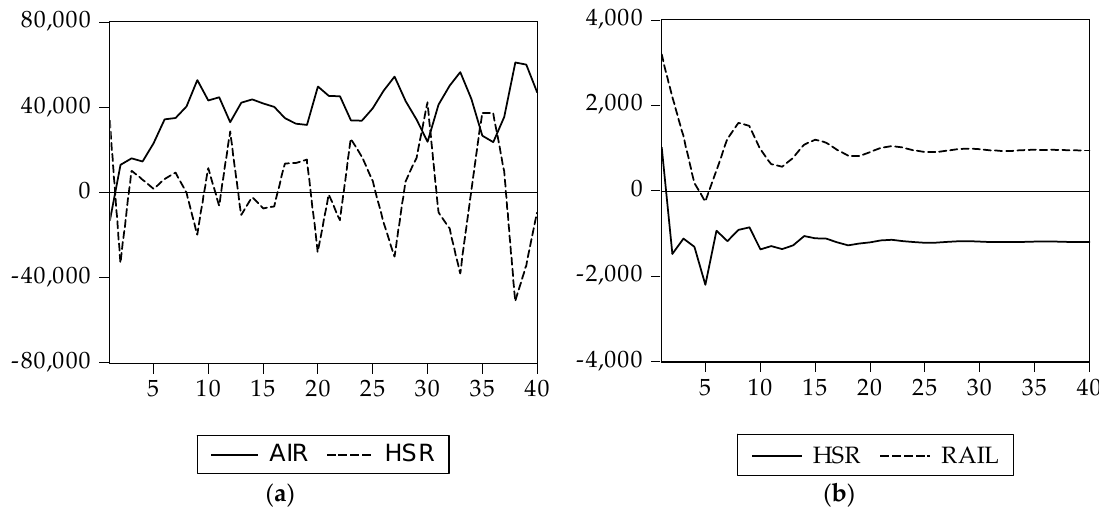
Figure 4. Impulse responses for the three transport modes. ( a ) Response of HSR to one standard deviation (S.D.) innovations; ( b ) Response of RAIL to one S.D. innovations.